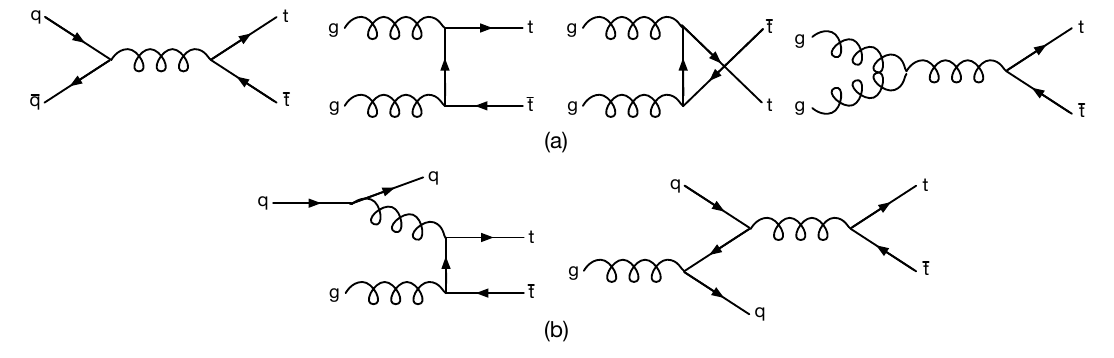
Figure 1 . (a) Feynman diagrams for LO qq- and gg-initiated tt subprocesses, and (b) example diagrams for the NLO qg-initiated subprocess.